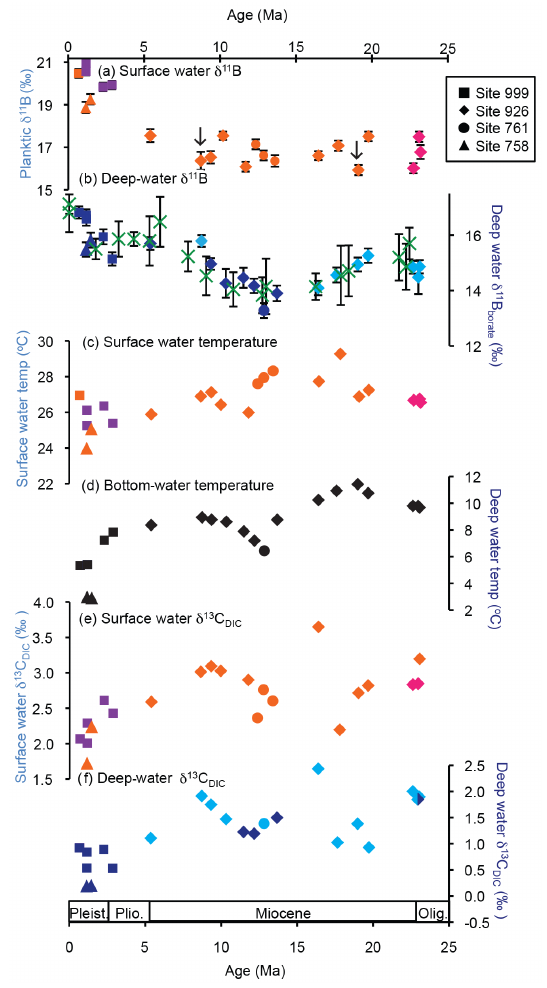
Figure 6. δ 11 B planktic , temperature and δ 13 C DIC estimates for the surface and deep ocean through the last 23 million years. (a) δ 11 B planktic surface; (b) δ 11 B borate deep from ben- thic foraminifera (blue) from this study and (green) Raitzsch and Hönisch (2013). The error bars show the analytical external re- producibility at 95% confidence for this study. For the Raitzch and Hönisch (2013) data the error bars represent propagated un- certainties of external reproducibilities of time equivalent benthic foraminifer samples from different core sites in different ocean basins; (c) Mg / Ca based temperature reconstructions of surface dwelling planktic foraminifera; (d) deep-water temperature esti- mates from Cramer et al. (2011); (e) δ 13 C DIC surface record; and (f) δ 13 C DIC benthic record. Squares depict ODP Site 999, trian- gles are ODP Site 758, diamonds are ODP Site 926 and circles are ODP Site 761. Species are highlighted by colour: Orange is T. trilobus , purple G. ruber , pink G. praebulloides , dark blue Cibici- doides wuellerstorfi and light blue Cibicidoides mundulus . The two benthic–planktic pairs that were removed prior to smoothing are highlighted with arrows.